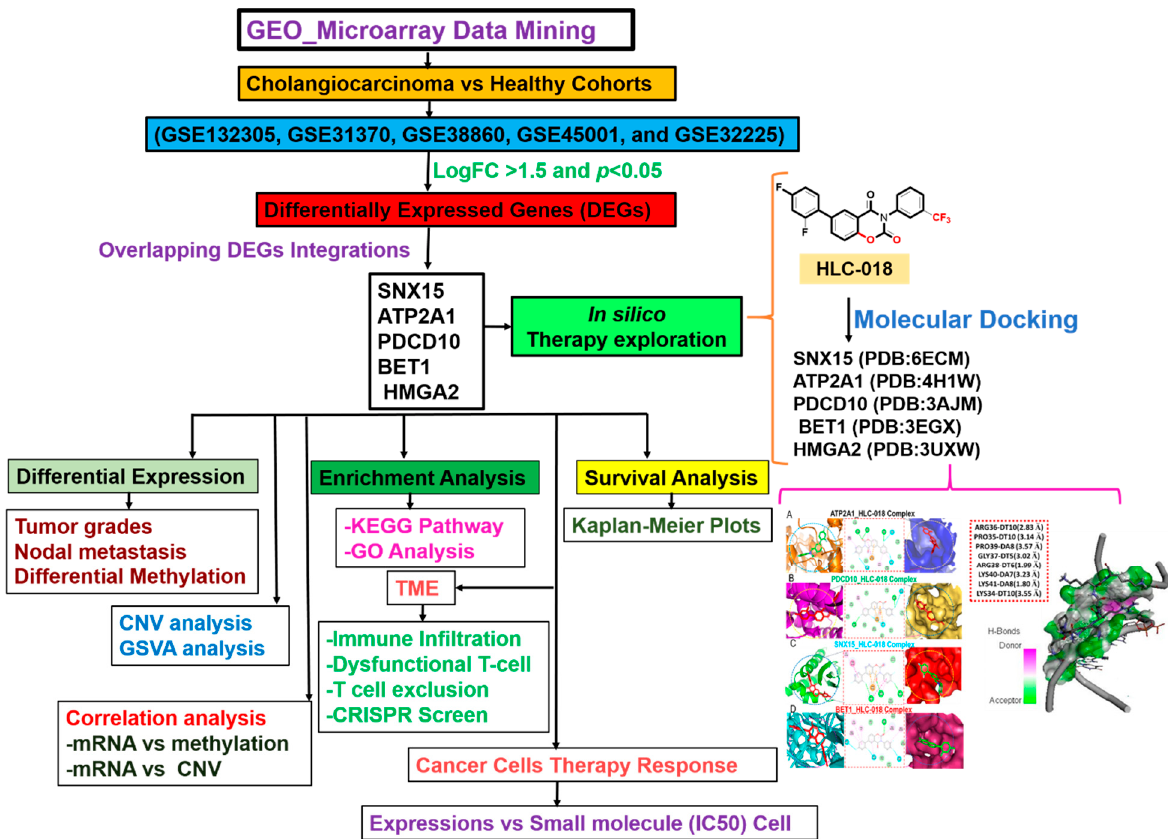
Figure 1. Schematic flow chart of the study design for identifying and characterizing the pathological role of DEGs in cholangiocarcinoma and in silico exploration of HLC-018 as a potential therapeutic candidate.